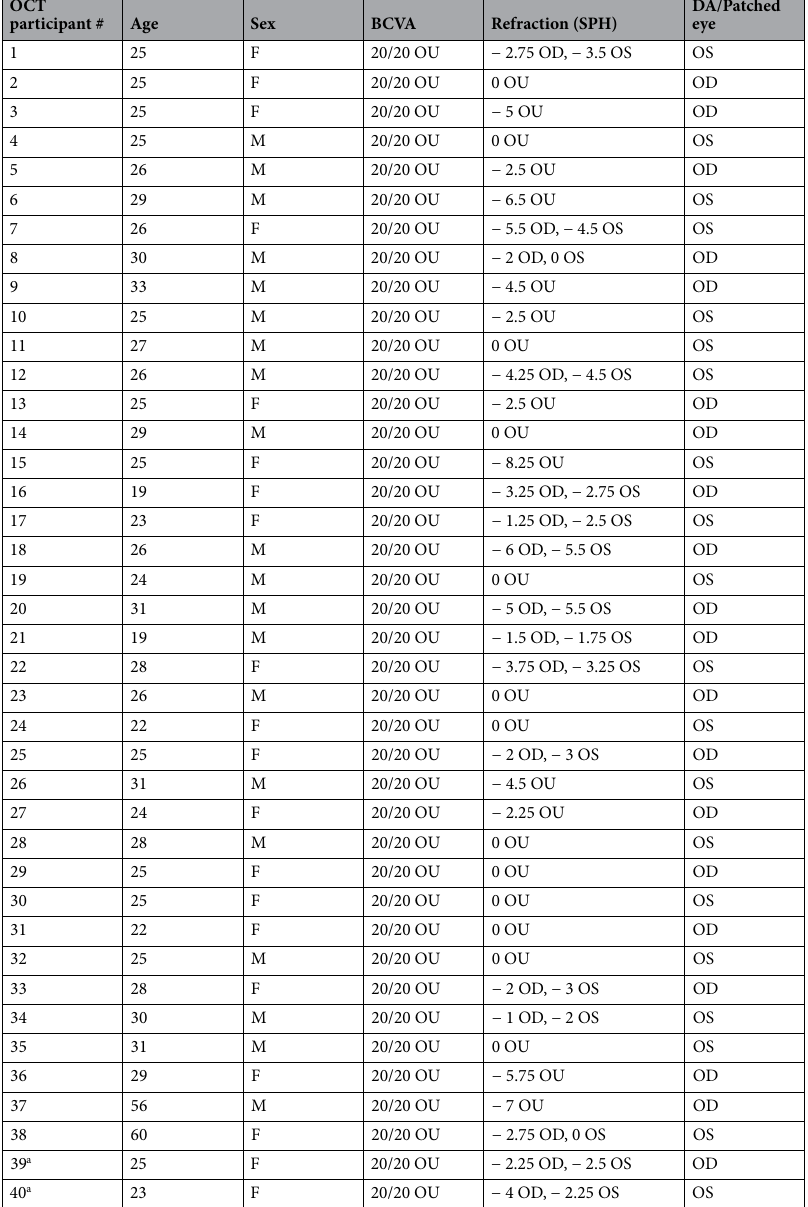
Table 1. Subject demographics. Includes age, sex, best corrected visual acuity (BCVA), refraction (sphere) for each eye, and which eye was dark adapted/patched ( a excluded from